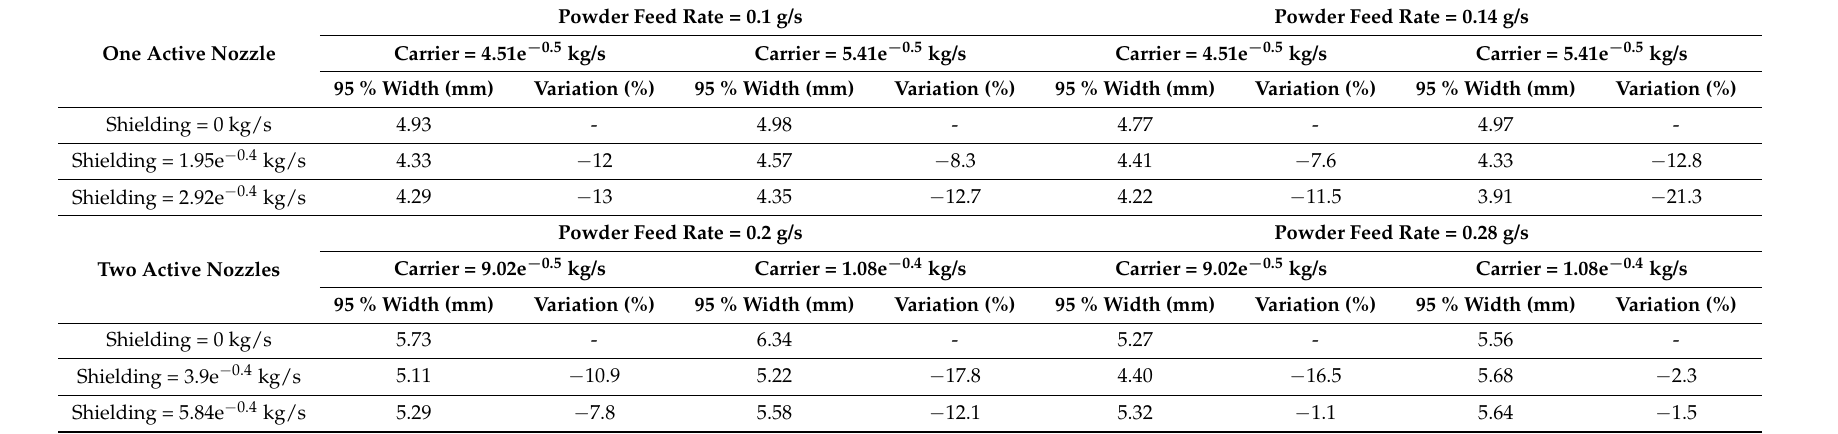
Table 2. Summary of the experimental results without the presence of the